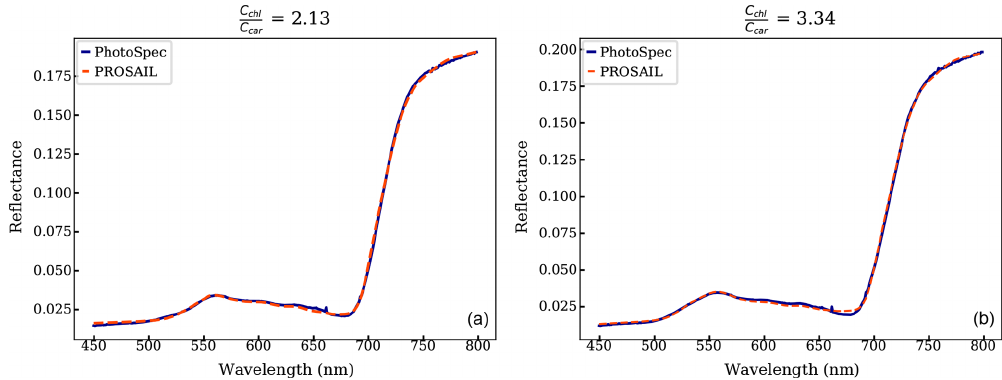
Figure C1. The observed and fitted reflectance spectra at low (a) and high (b) C chl